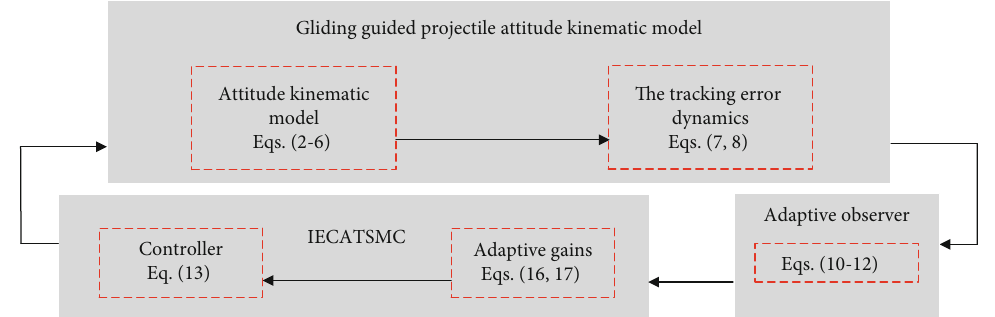
Figure 1: Schematic diagram of the proposed control strategy.